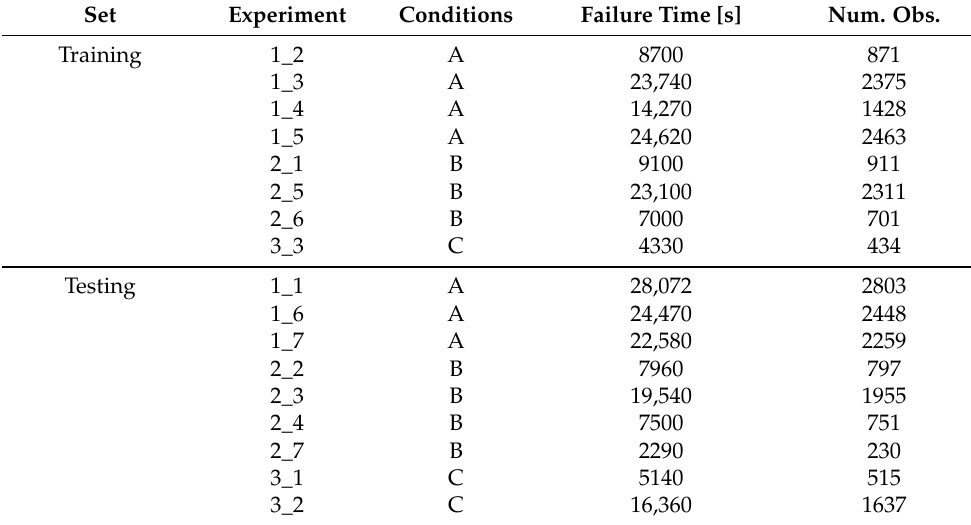
Table 2. FEMTO bearings dataset, training/test